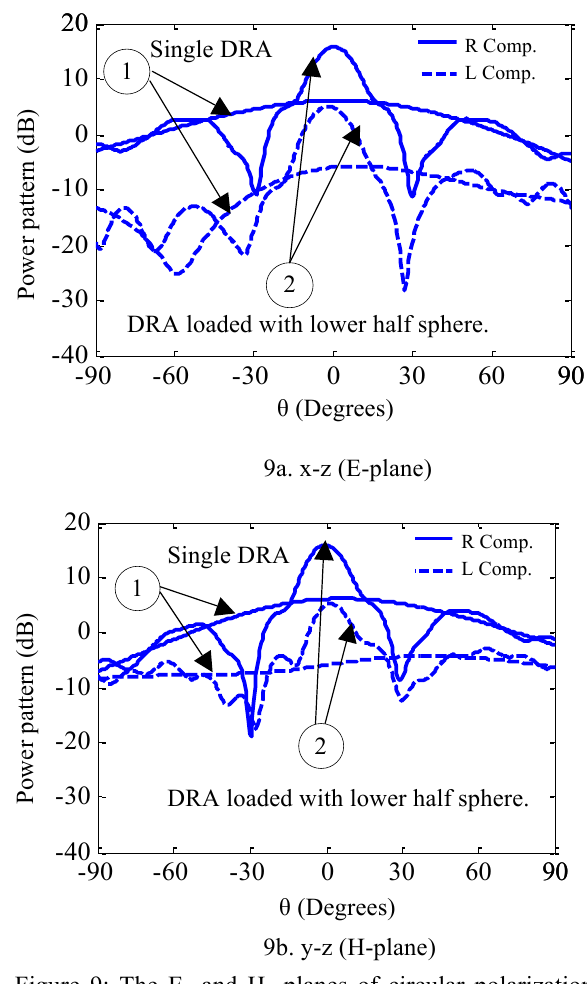
Figure 9: The E- and H- planes of circular polarization radiation patterns for the DRA loaded with lower half dielectric sphere compared to a single DRA at f = 10